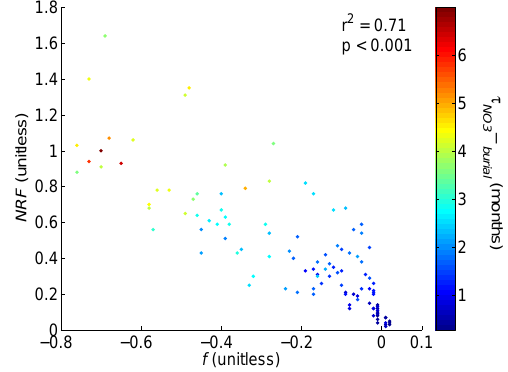
Figure 13. NRF versus f values across Greenland. The color scale represents the minimum number of months that NO − ) photic zone ( τ NO − 3 burial